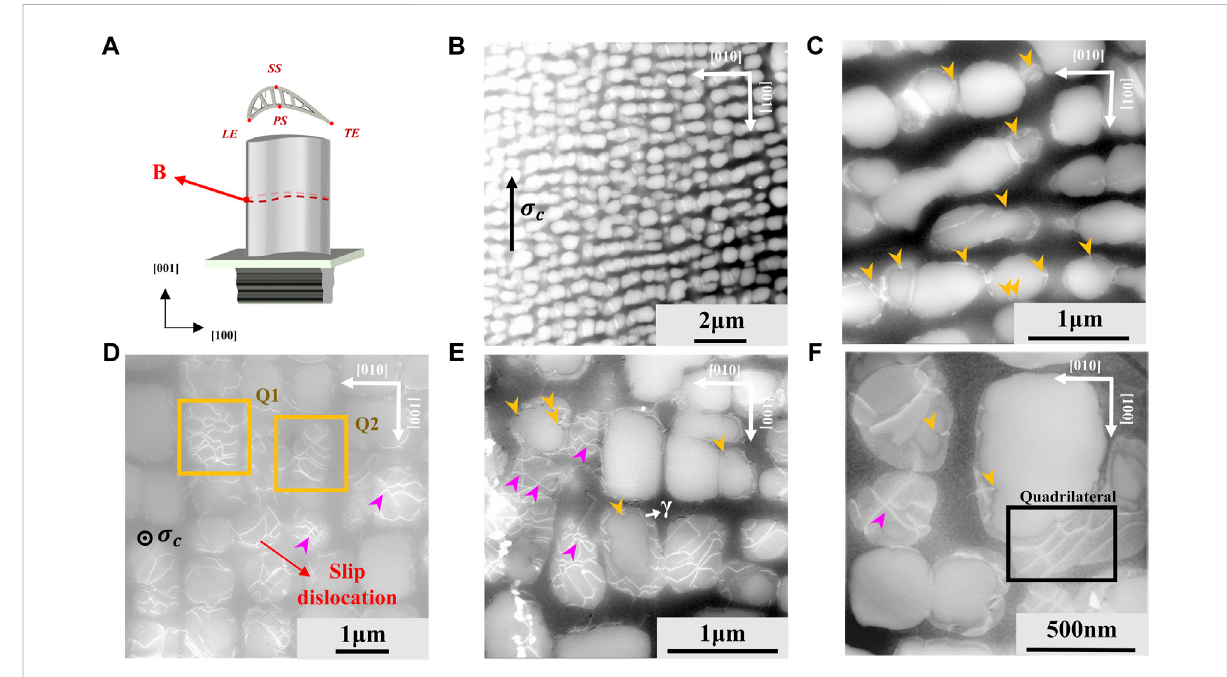
FIGURE 3 Microstructures at point B (A) the position of point B on the blade, (B) morphologies of rafted γ ′ precipitates and (C) dislocations observed at < 100 > direction, (D – F) morphologies of γ ′ precipitates and behavior of dislocations observed at < 001 > direction.